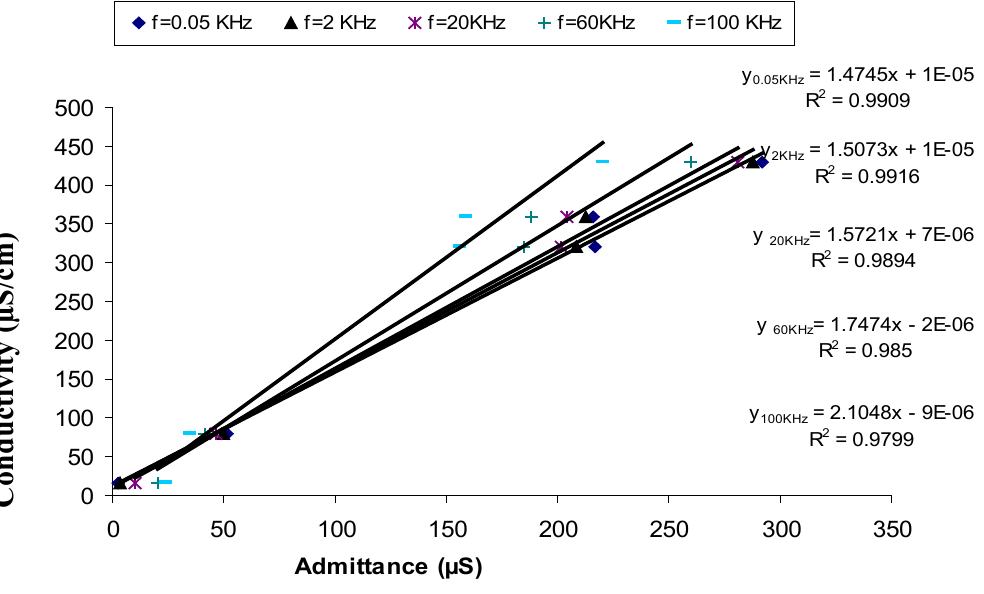
Figure (3): The linear relationship between admittance and conductivity at frequencies (0.05, 2, 20, 60 and 100 kHz) for the 2-inner electrodes system.